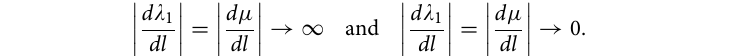
The RG flow lines for the coupling parameters (cid:31) 1 and µ is shown in Fig. 10. Quantum critical line and fixed line are represented as solid and dashed lines respectively. The line (cid:31) 1 multi-critical points for different values of µ . This line distinguish between the w gapless phases on the critical line (cid:31) 2 through the multi-critical point. The dashed line in Fig. 10, (cid:31) 1 The intersection of critical and fixed lines can be obtained analytically at µ